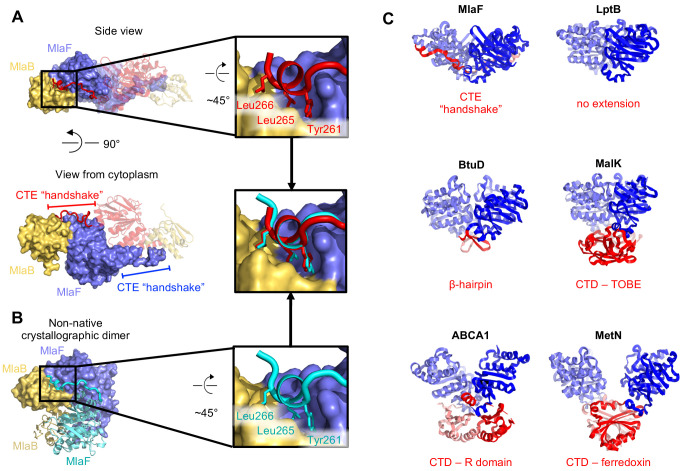
C-Terminal Extension (CTE) of MlaF dimer adopts a unique conformation, forming a ‘handshake’ with the adjacent monomer.(A) MlaF2B2 structure with one heterodimer shown in surface representation (MlaF, purple; MlaB, yellow) and the other represented as a cartoon (MlaF, red; MlaB, yellow). The CTE from one MlaF monomer (red) docks at the MlaFB interface of the other MlaF monomer. Inset shows three hydrophobic residues of the CTE that dock at the MlaF/MlaB interface. (B) Crystal structure of MlaF1B1 crystallographic (non-native) dimer in which CTE contacts are still maintained. Inset shows the three hydrophobic residues in the CTE, for which interactions to the MlaFB interface are maintained in the non-native arrangement. (C) Comparison of C-terminal regions from different ABC transporters, among which the MlaF CTE is unique (PDB IDs: 6MI8 [Li et al., 2019], 2QI9 [Hvorup et al., 2007], 1Q12 [Chen et al., 2003], 5XJY [Qian et al., 2017], 3DHW [Kadaba et al., 2008]).